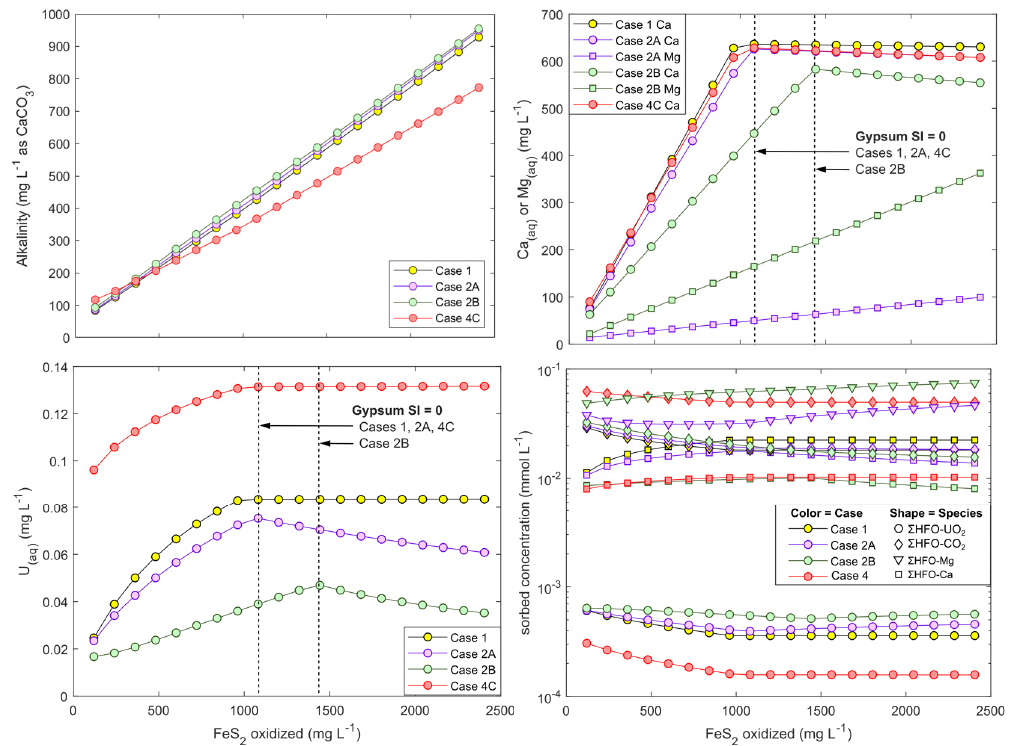
Figure 8. Modeled alkalinity ( top left ), Ca and Mg ( top right ), and U ( bottom left ) concentrations, and sorbed species ( bottom right ) onto HFO in hypothetical batch reactions involving FeS 2 oxidation in the presence of excess carbonate. Arrows indicate approximately when gypsum mineral saturation index reaches 0. The different modeling scenarios are presented in Table 2. The HFO composition that are shown at bottom right are the respective millimolar sums of all U, DIC, Mg, and Ca species that are sorbed in each simulation.